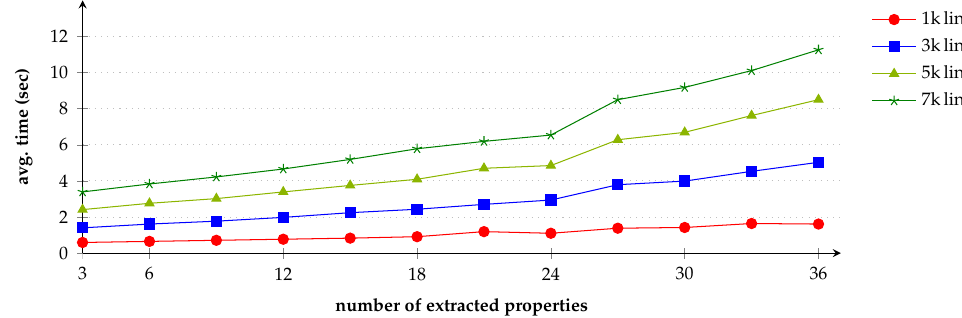
Figure 11. Average log graph generation time for n log lines with a single host (36 extracted properties)